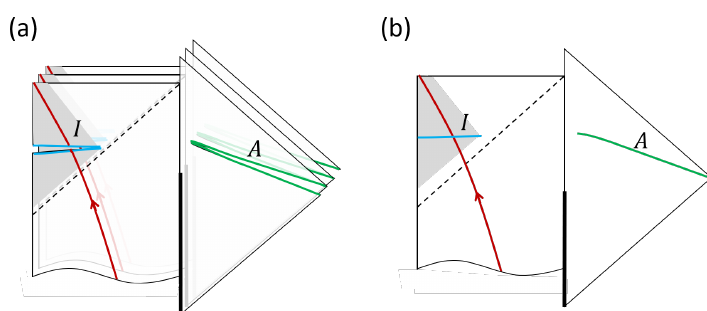
Figure 1 . (a) Illustration of the replica manifold with branch-covering at A and possibly an island region I . (b) In the analytic continuation to n → 1 limit, illustration of the quantum extremal surface (2.3) which is the boundary of I